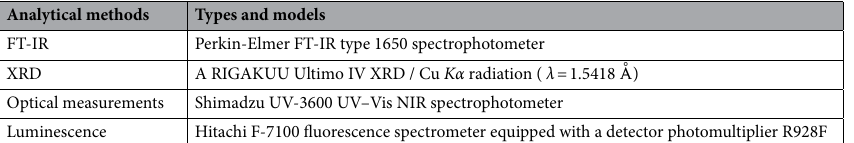
Table 1. List of analysis methods and equipment.